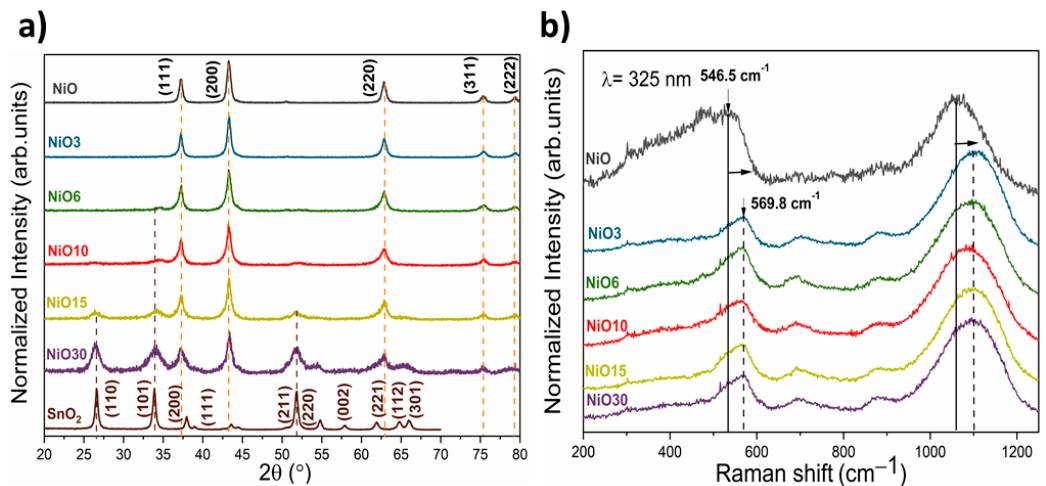
Figure 2. ( a ) XRD patterns from undoped and Sn doped NiO samples. XRD pattern from SnO 2 is also included as reference. ( b ) Raman spectra from undoped and Sn doped NiO samples acquired with a UV laser ( λ = 325 nm).